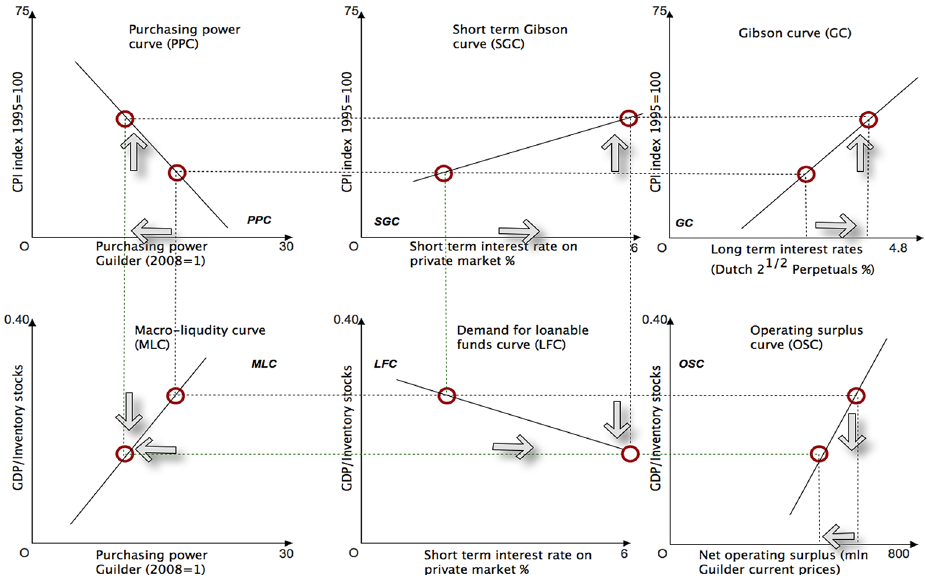
Fig. 2 . Gibson paradox curve model (the Netherlands 1850–1900) Source : authors’